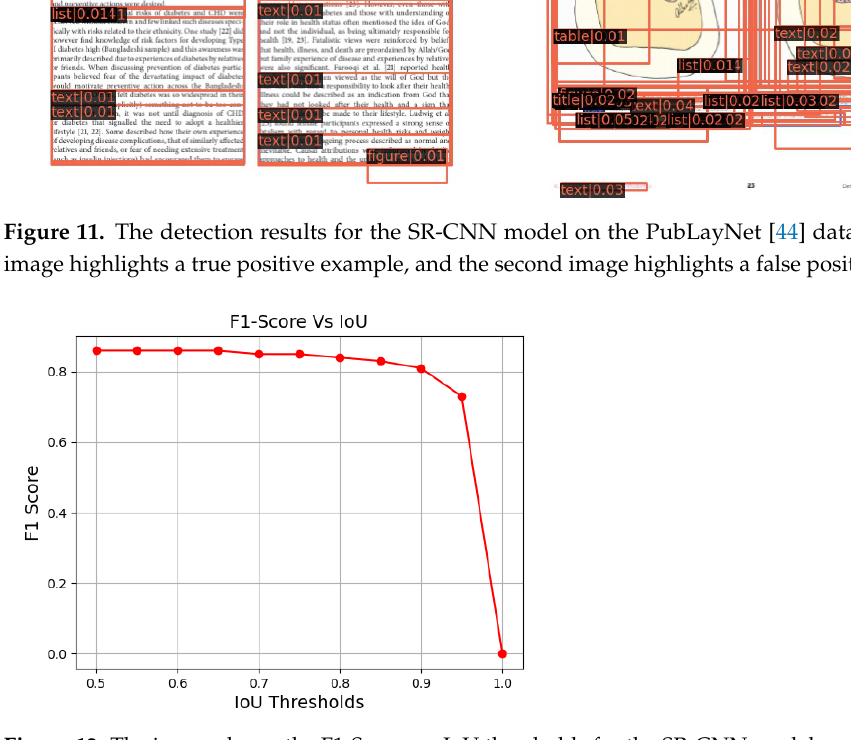
Figure 12. The image shows the F1-Score vs. IoU thresholds for the SR-CNN model on the test set for the PubLayNet [44]